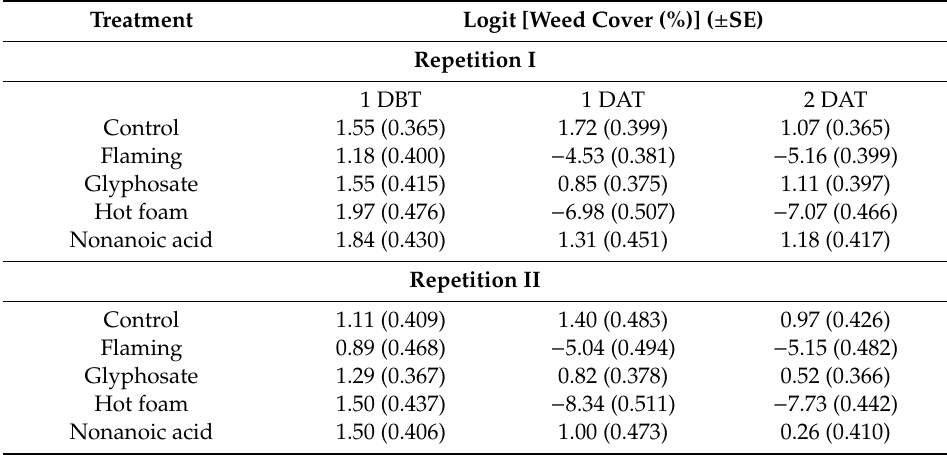
Table 2. Weed control least squares means and standard errors (SE) of weed cover percentage logit transformed as a ff ected by the di ff erent treatments, repetition of the experiment, and evaluation date (one day before, and one and two days after treatments) at site